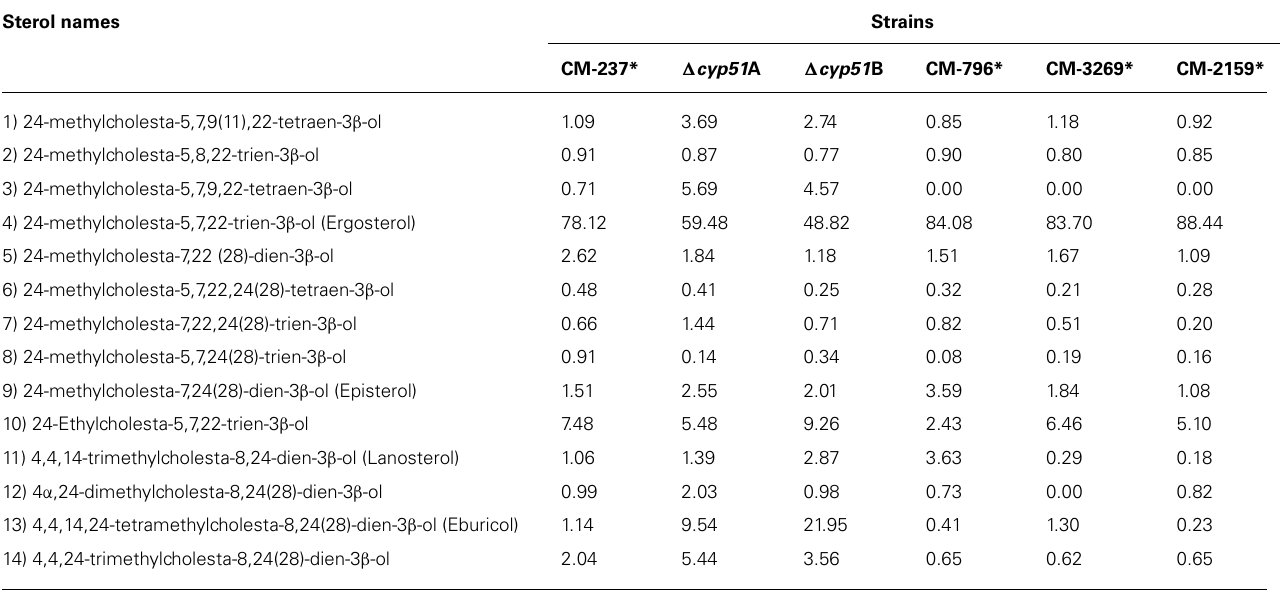
*Geometric mean of MICs to antifungal agents of A. fumigatus strains: CM-237: ITC (0.25 μ g/ml), VRC (0.48 μ g/ml), POS (0.06 μ g/ml), FLC (1094.55 μ g/ml), AMB (0.26 μ g/ml),TRB (5.4 μ g/ml); CM-796: ITC (16 μ g/ml), VRC (1.19 μ g/ml), POS (1.68 μ g/ml), FLC (1094.55 μ g/ml), AMB (0.15 μ g/ml),TRB (2.38 μ g/ml; CM-2159: